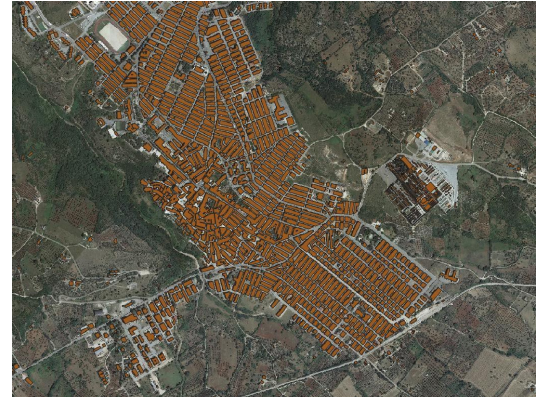
Figure 2 . Example of digitization of urban